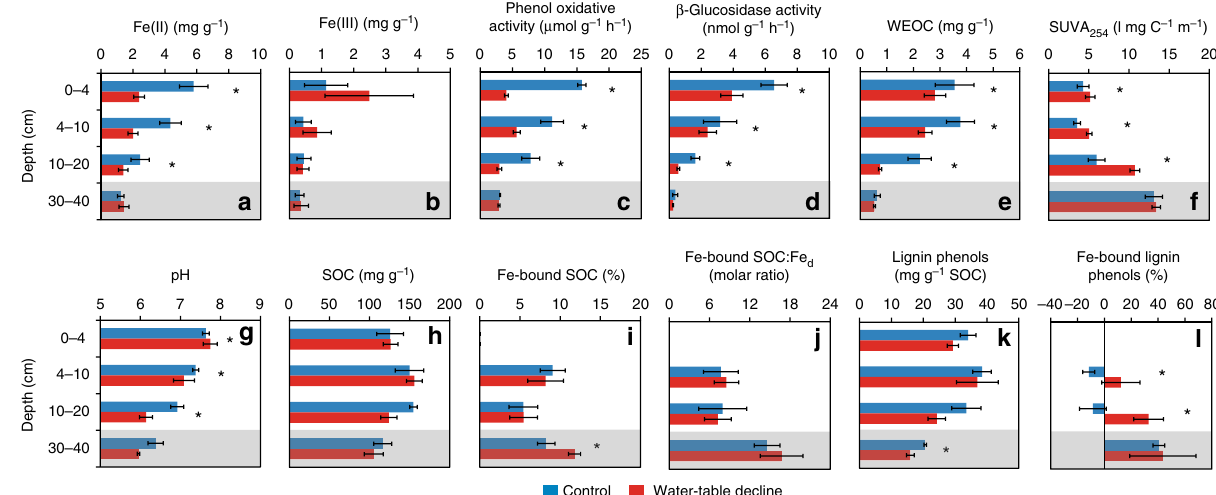
Figure 2 | Changes in enzyme activities and soil chemical properties at different depths in the wetland water-table decline experiment. ( a ) Ferrous iron [Fe(II)]; ( b ) ferric iron [Fe(III)]; ( c ) phenol oxidative activity; ( d ) b -glucosidase activity; ( e ) water-extractable organic carbon (WEOC); ( f ) specific ultraviolet absorbance at 254nm of WEOC (SUVA 254 ); ( g ) soil pH; ( h ) soil organic carbon (SOC); ( i ) iron-bound soil organic carbon (Fe-bound SOC) calculated by equation (1); ( j ) the molar ratio of Fe-bound SOC to dithionite-extractable iron (Fe d ); ( k ) SOC-normalized content of lignin phenols; ( l ) Fe-bound lignin phenols calculated by equation (2). The shaded soil layer (30–40cm) was submerged under water in both treatments, whereas the other layers were air-exposed in the water-table decline treatment. Error bars represent s.e.m. ( n ¼ 4). Asterisk denotes significant difference between control and water-table decline treatments ( P o 0.05). Note that Fe(II), Fe(III), pH and enzyme activities were measured for bulk soils whereas other properties were measured for the fine soil fraction ( o 53 m m). Fe-bound SOC and lignin phenols were not measured at 0–4cm due to the limited sample size.